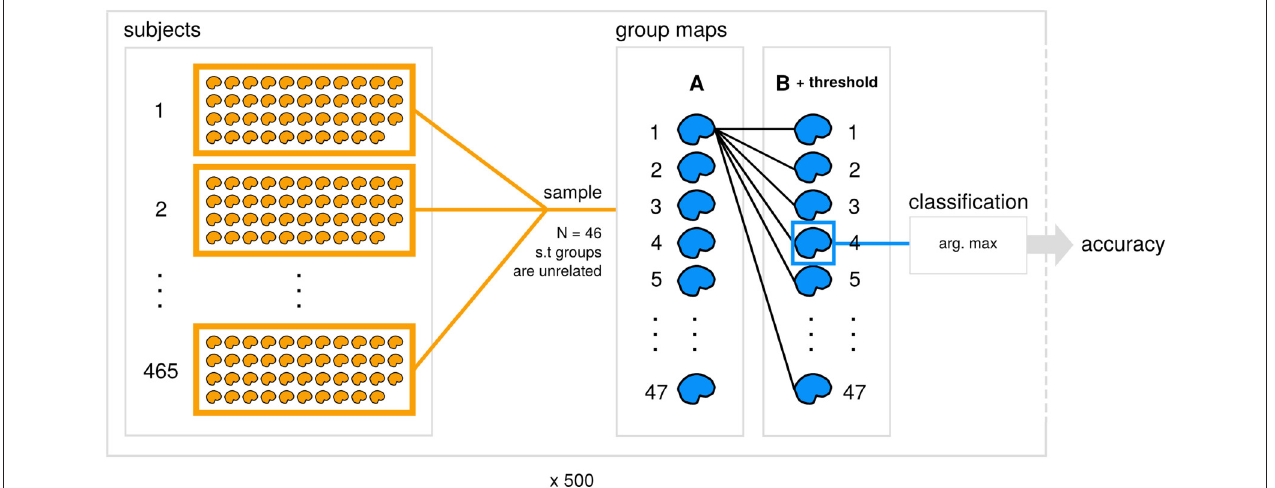
FIGURE 1 | Data generation and analysis process. A subset of 465 datasets from the Human Connectome Project (subjects) is used to generate 47 contrast maps (group maps) for each of groups A and B for 500 subsamples. Within each subsample, an unthresholded image from A is compared with each thresholded image from B with a particular similarity metric and comparison strategy applied. Each image from A is then assigned the predicted class for the max. arg from the set of B, and accuracy is calculated for the subsample.